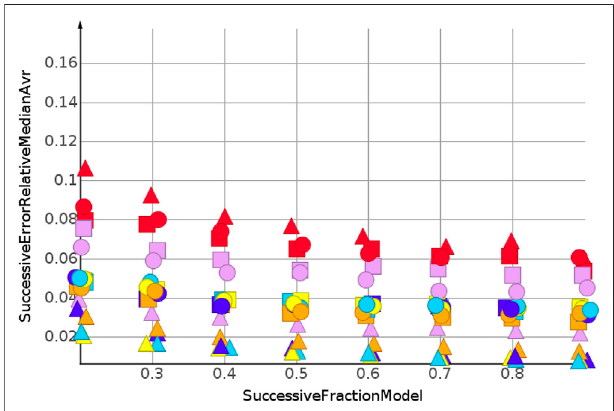
FIGURE 3 | Prediction of molecular weight, random shuf fl